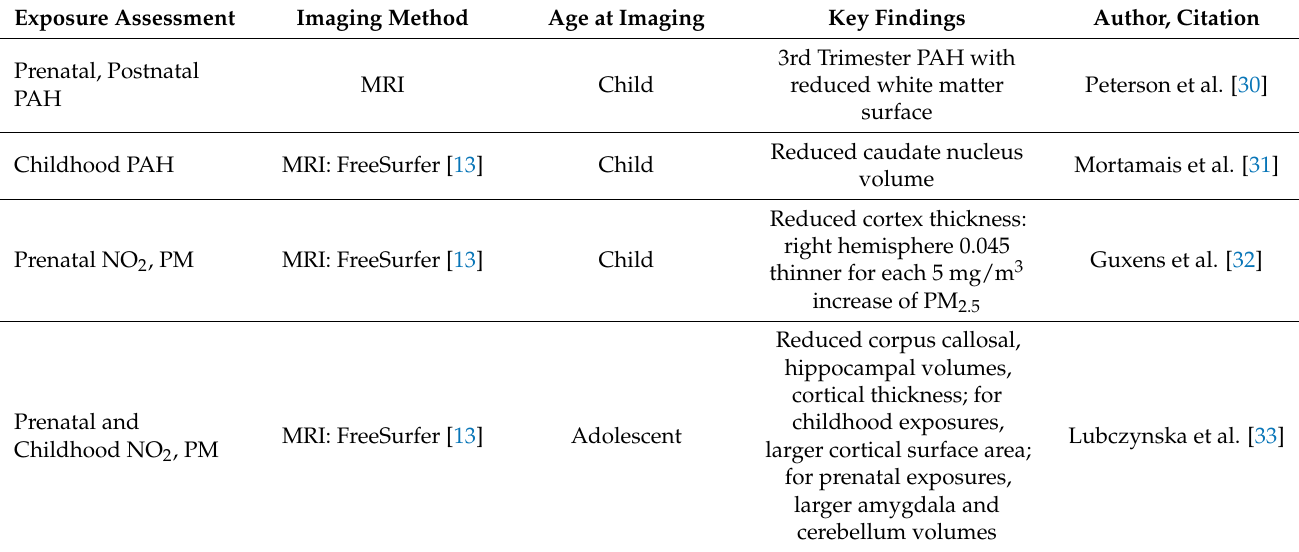
Table 2. Summary of neuroimaging findings associated with air